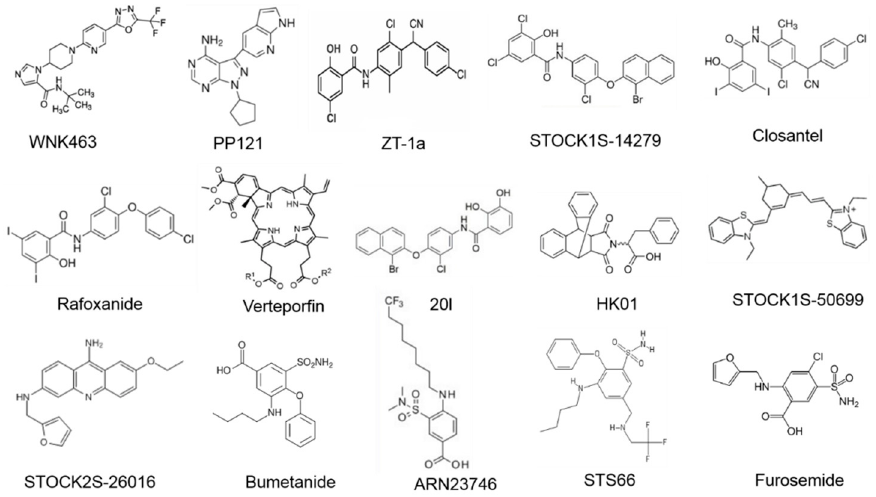
Figure 3. Molecular structures of WNK-SPAK/OSR1-CCCs signaling pathway compounds.